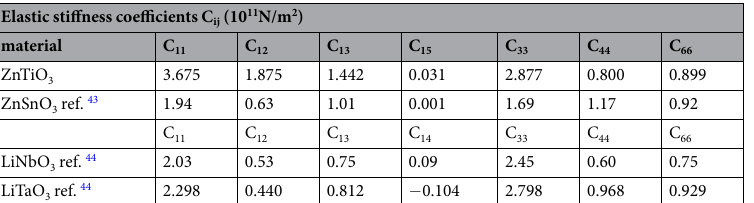
Table 7. The Elastic stiffness coefficients of LN-type ZnTiO 3